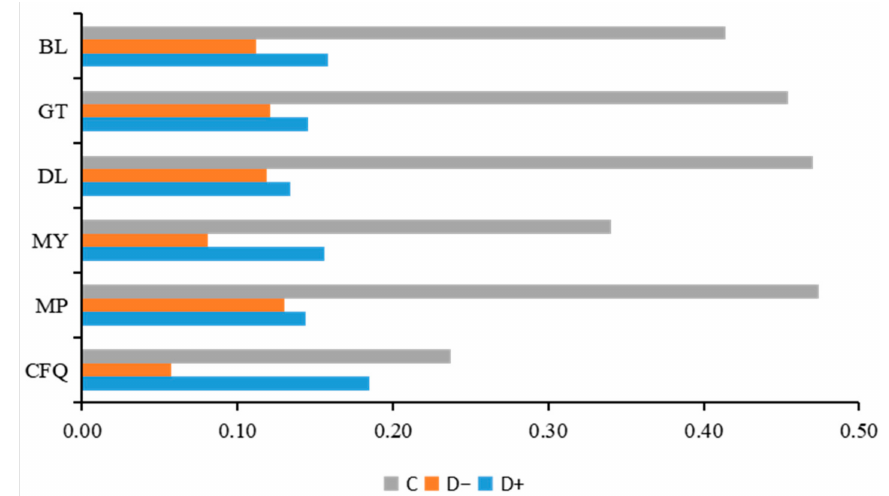
Figure 6. Evaluation of the closeness of rural revitalization in